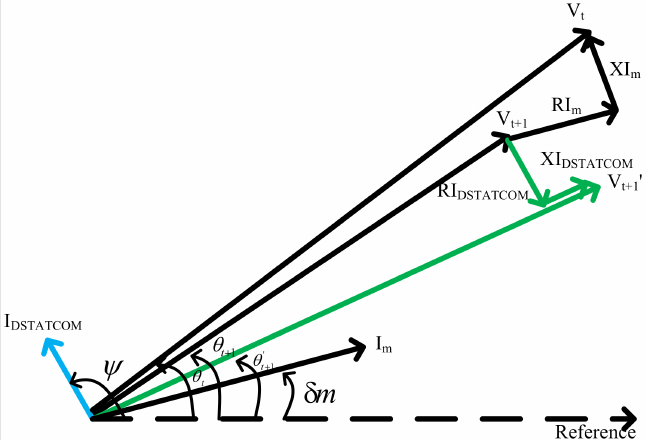
Figure 5. Phasor diagram of two consecutive nodes of a PDN with D-STATCOM at ( t + 1)th